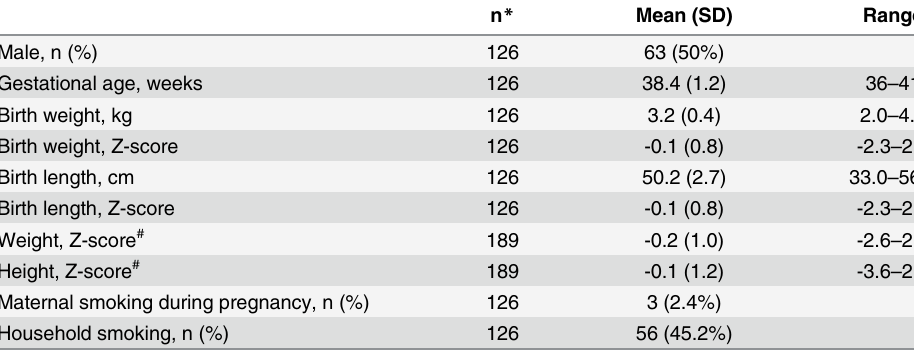
Table 1. Demographic characteristic of 189 lung function tests on 126 infants.